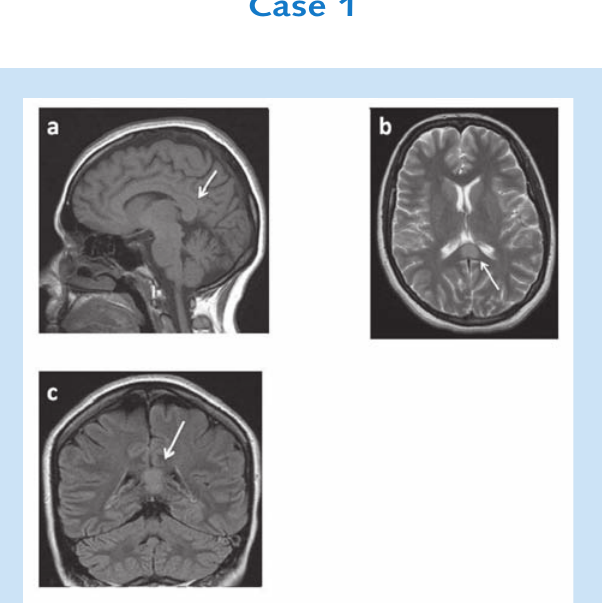
Fig. 3. Follow-up MRI study demonstrates complete resolution of the splenial lesion with no residual abnormal signal on any sequence. (a) ADC map; (b) B-1000 diffusion-weighted image; (c) The coronal FLAIR